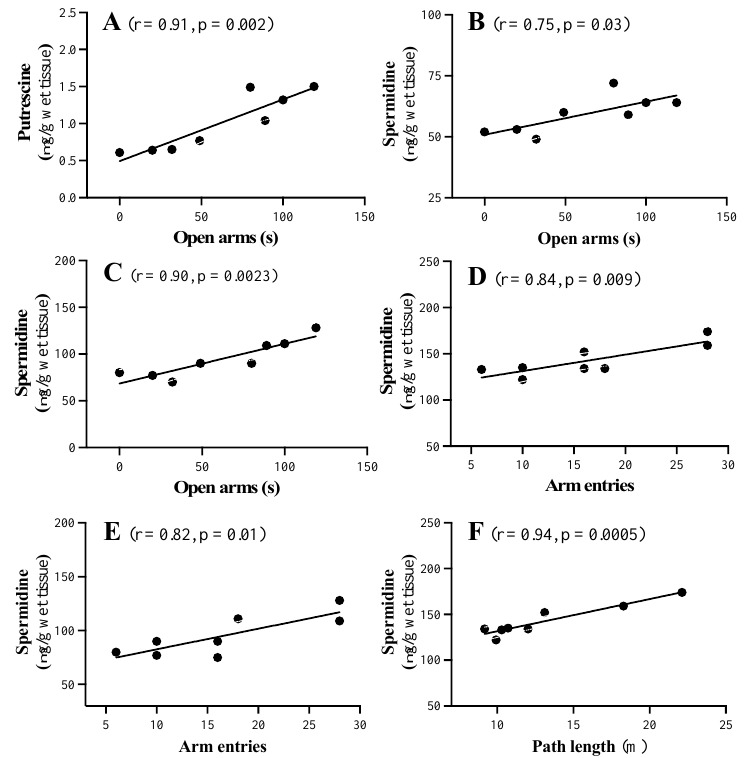
Figure 7. Scattergrams showing the significant correlations between the time spent in the open arms of the elevated plus-maze test and putrescine in the frontal cortex ( A ), spermidine in the frontal cortex ( B ) and parahippocampal region ( C ), between the total number of arm entries in the elevated plus-maze and spermidine in the hippocampus ( D ) and parahippocampal region ( E ) and between the total path length generated in the open field test and spermidine in the hippocampus ( F ), in 8-month-old PS19 mice.